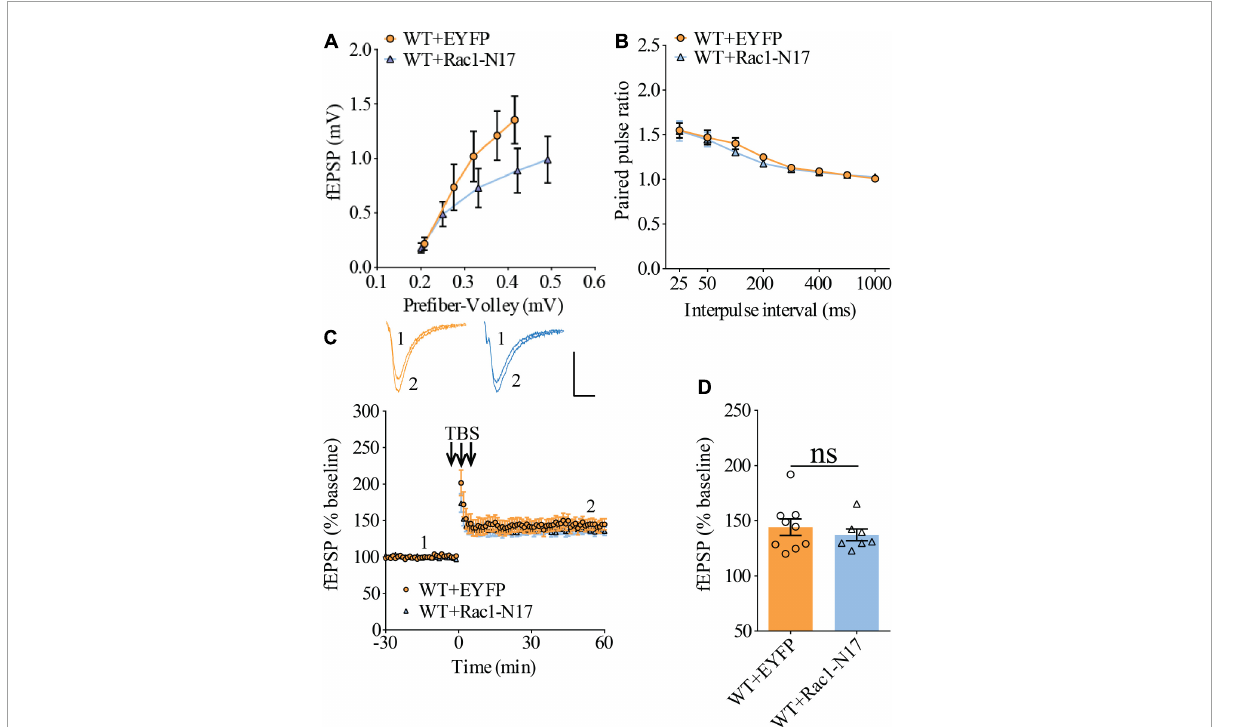
FIGURE4 Normal LTP in WT mice overexpressing Rac1-N17 in ventral hippocampus. (A) Input–output curves of fEPSP showing no differences between WT mice expressing EYFP and Rac1-N17 (WT + EYFP n = 6 slices from 5 mice, WT + Rac1-N17 n = 6 slices from 4 mice; genotype: F ( 1 , 10 ) = 1.187, p = 0.301; prefiber volley: F ( 4 , 40 ) = 35.10, p < 0.001; repeated two-way ANOVA). (B) Paired pulse ratio showing no differences between WT mice expressing EYFP and Rac1-N17 (WT + EYFP: n = 8 slices from 5 mice, WT + Rac1-N17: n = 6 slices from 4 mice; genotype: F ( 1 , 12 ) = 0.223, p = 0.645; inter-pulse interval: F ( 7 , 84 ) = 57.35, p < 0.001; repeated two-way ANOVA). (C) TBS induced similar LTP at the CA1 synapse in WT mice expressing EYFP and Rac1-N17. Scale bars: 0.4 mV/10 ms. (D) Summary graph of last 10 min of recording showing similar levels of LTP in